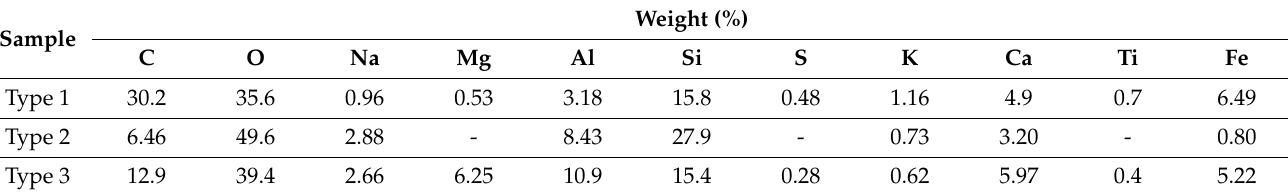
Table 8. Elemental composition by average weight (%) from mapping analysis.